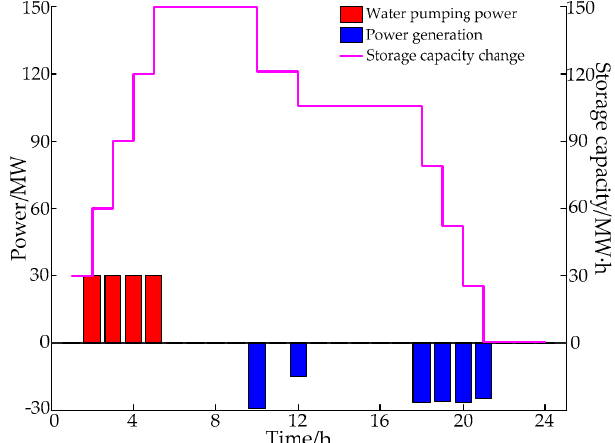
Figure 10. Changes of pumping and generating power and storage capacity of the PSPS.